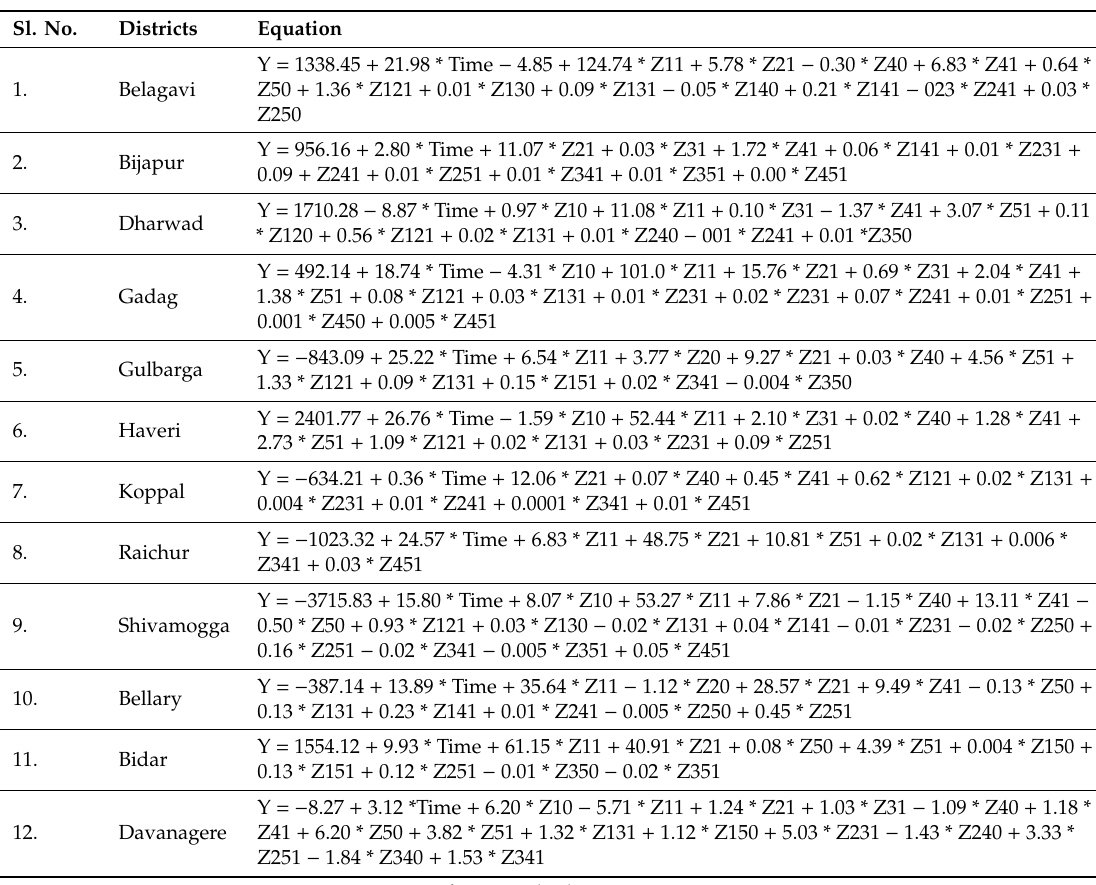
Table A2. Yield predicting equations derived from ENET for major sorghum growing districts of Karnataka without AET.